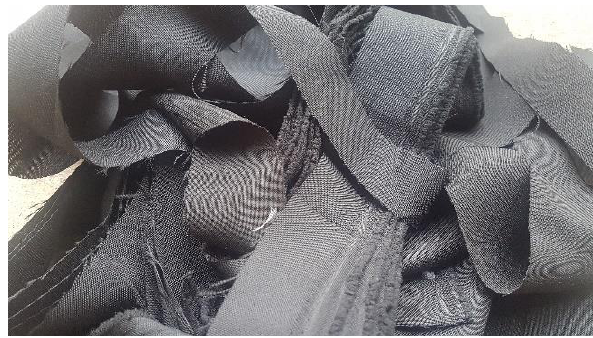
Figure 1. Polyester waste selected for this study